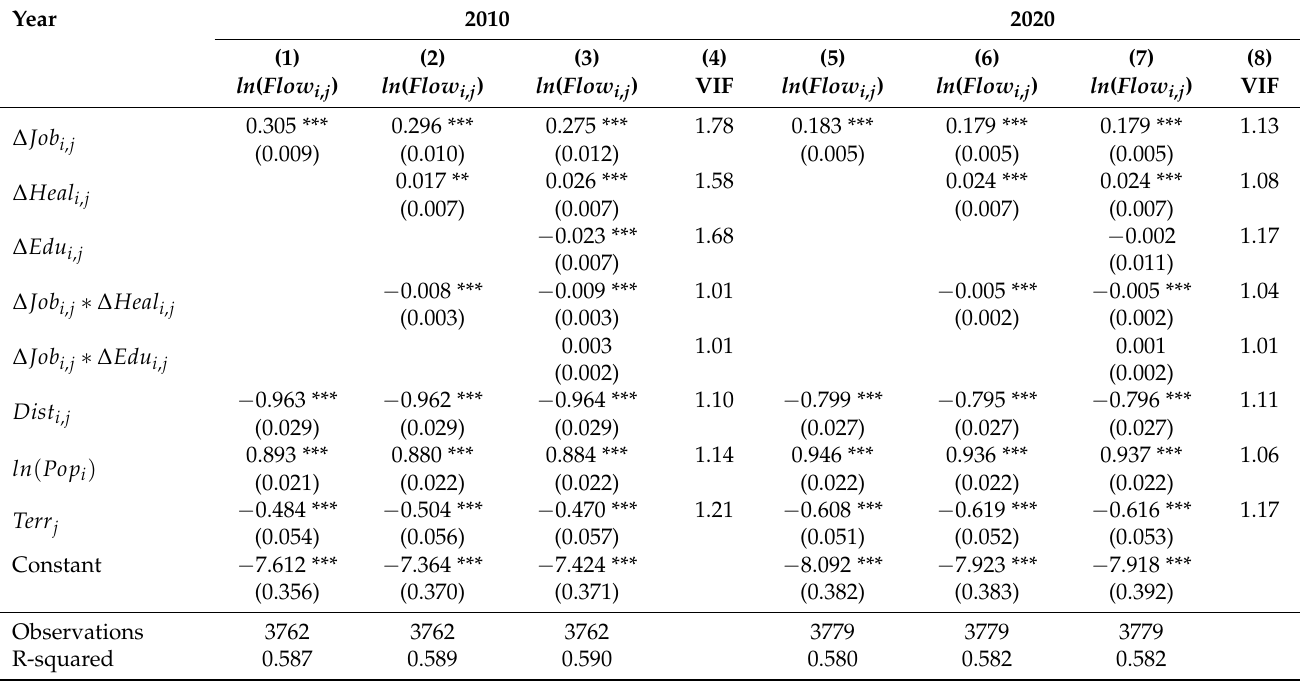
Table 2. The regression results of model